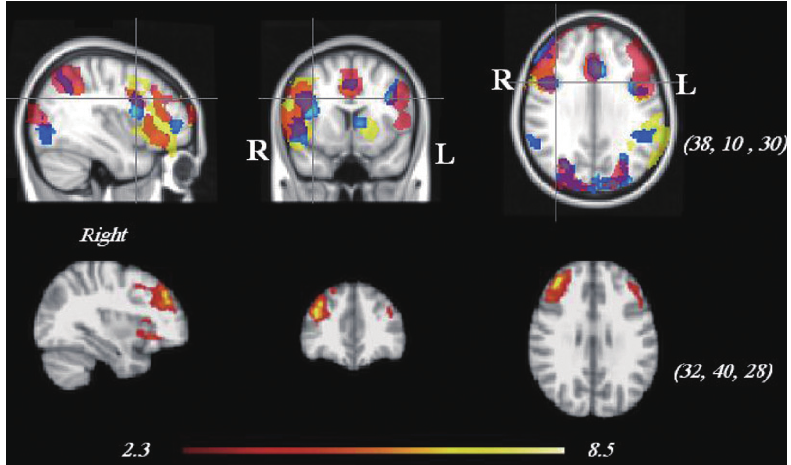
Fig. 2. Top: Group activation map for the visual, verbal and auditory working memory in all subjects (both groups). Bottom: Combined task analysis that shows frontal regions as shared activation across the tasks. Numbers in parentheses indicate “x”, “y” and “z” levels on sagittal, coronal, and axial